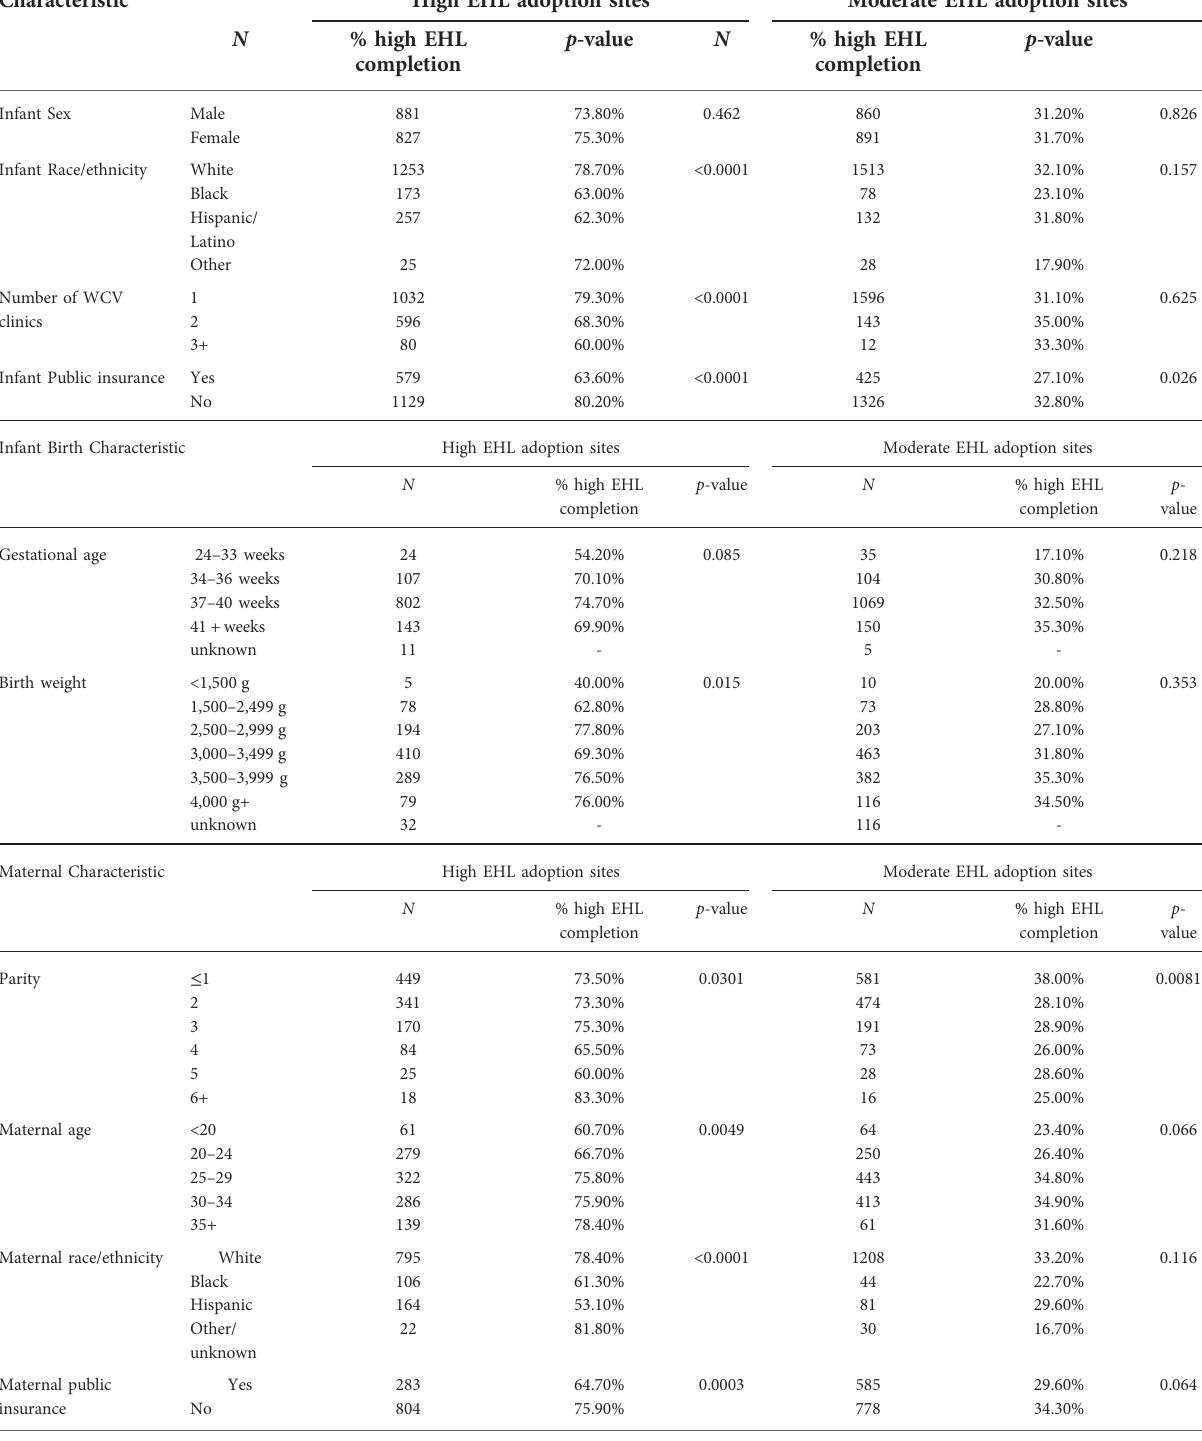
TABLE 4 Comparison of selected patient characteristics by completion